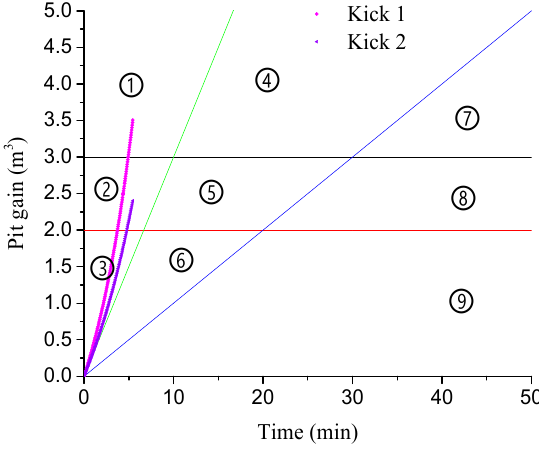
Figure 7. Kick severity analysis chart before well shut-in.